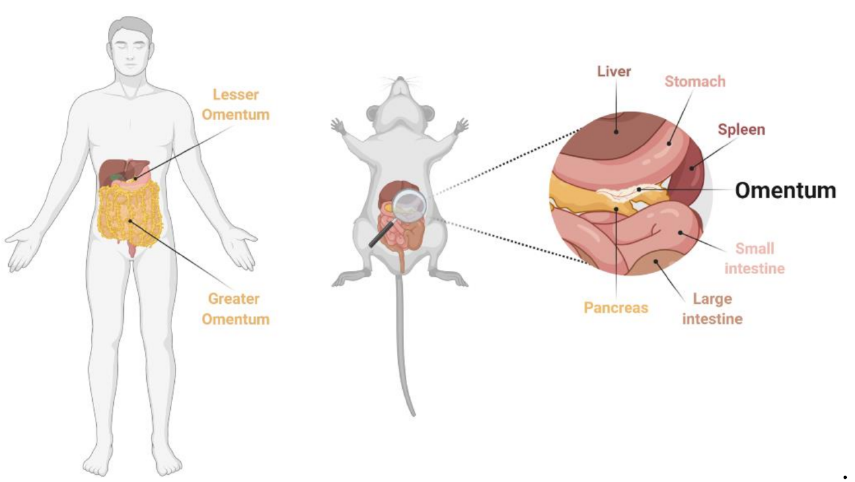
Figure 2. Anatomy and localization of human and mouse omentum. The mouse omentum is a thin, slightly elongated, and vascularized tissue located under the stomach and between the spleen and pancreas. Created with BioRender.com, accessed on 19 February